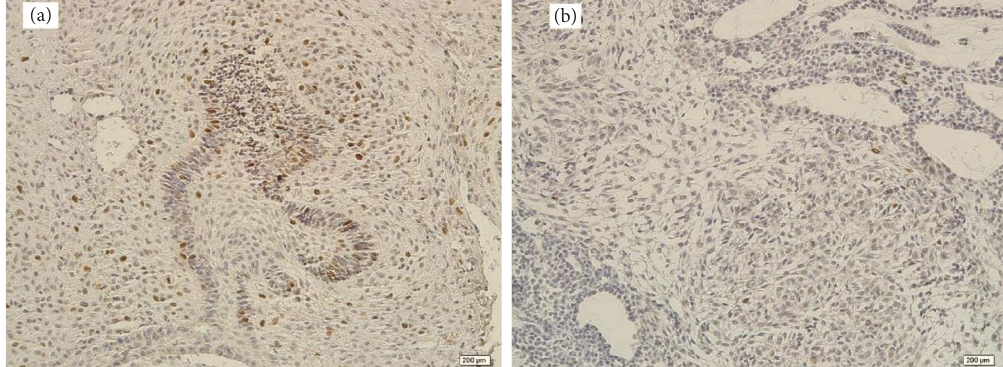
Figure 2: (a) Nuclear CDC7 expression in ameloblastic nests and stroma of ameloblastic fbroma ( × 200); (b) low and weak nuclear CDC7 expression in AOT ( ×